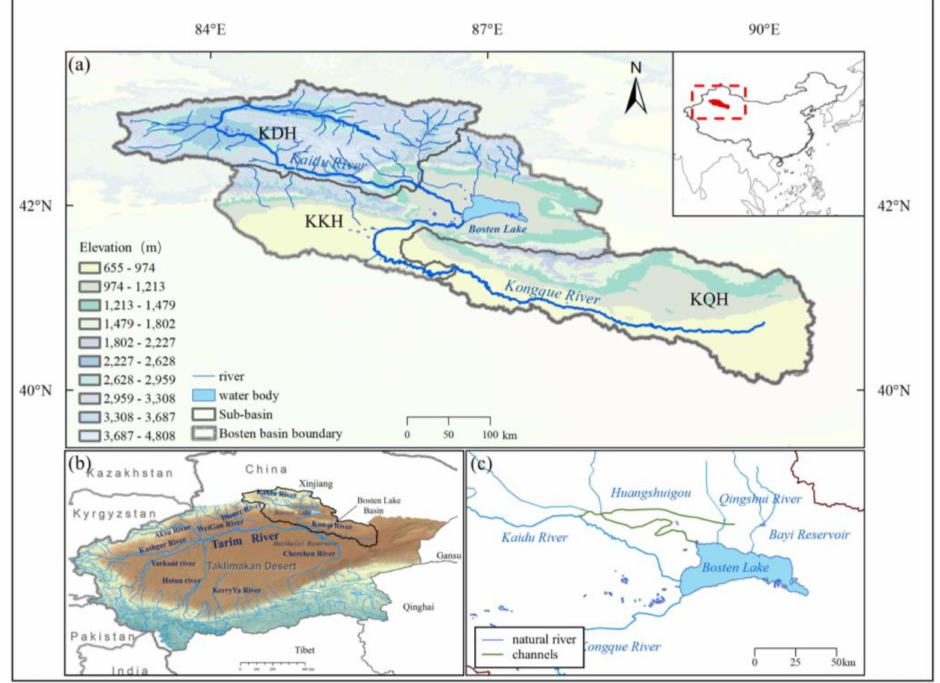
Figure 1. Location and overview of the Bosten Lake Basin. Scale and overview of the whole Bosten Lake Basin ( a ), location of the catchment within Tarim River Basin ( b ), enlarged view of the Bosten Lake ( c